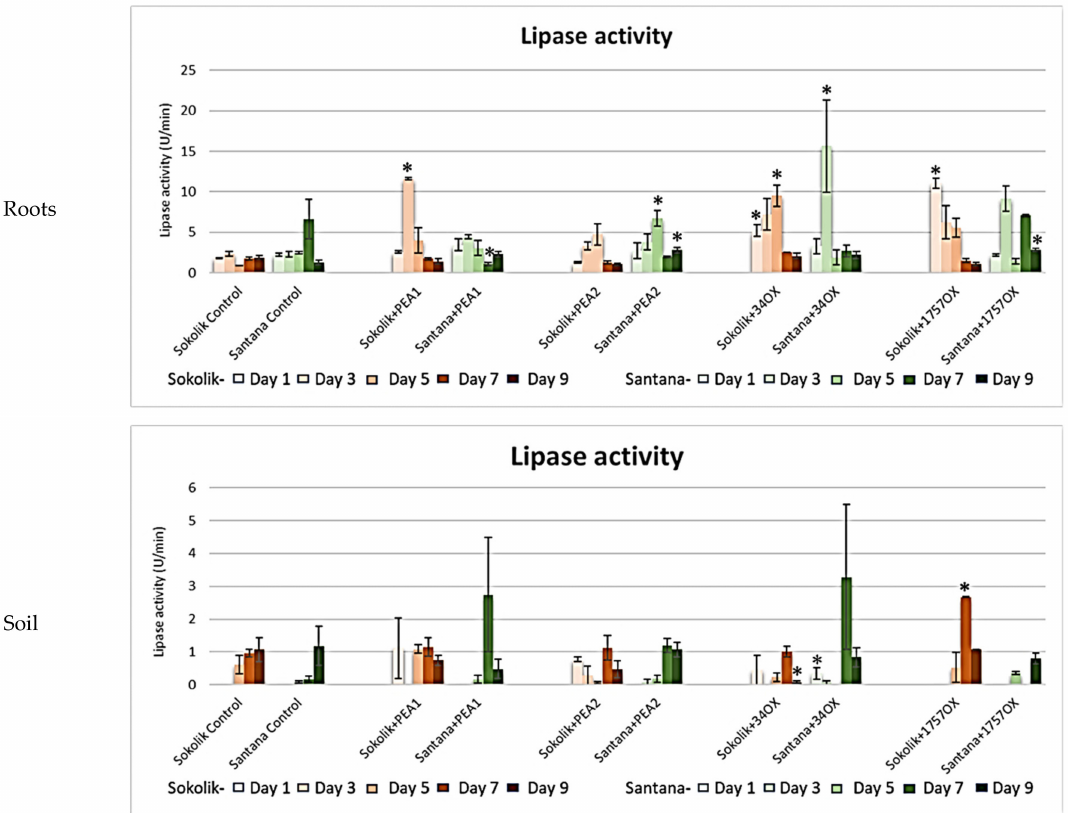
Figure 8. Lipase activity (micrograms of p-nitrophenol produced per minute (U/min)) obtained from the roots and soil of Sokolik and Santana infected with PEA1, PEA2, 34OX and 1757OX and the control (calculated from triplicate treatments). Error bar represents the standard error. * Statistically significant ( p <